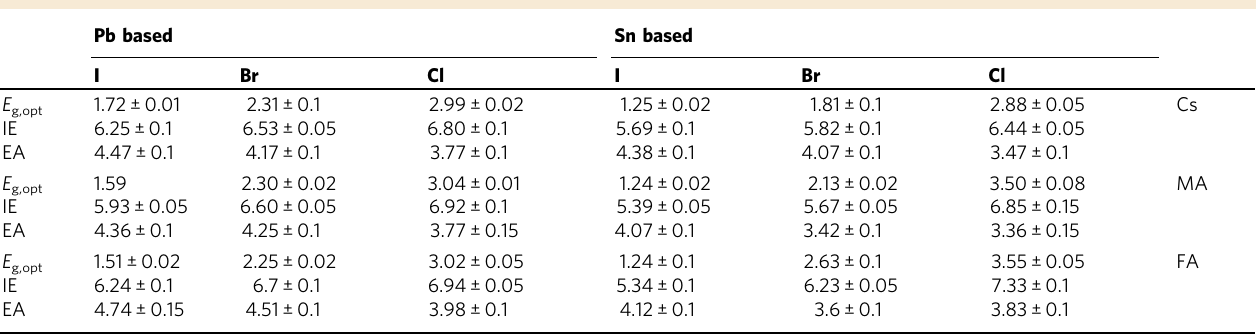
Table 1 List of extracted IEs, EAs, and optical band gaps E g,opt Pb based